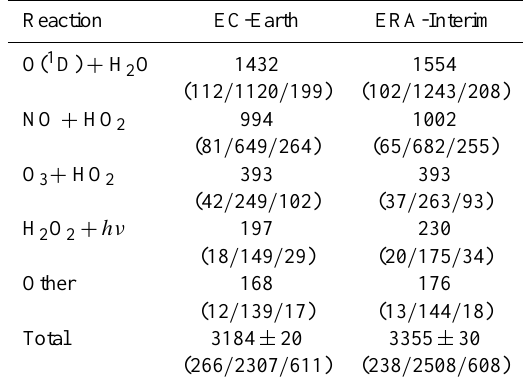
Table 3. Contributions to the chemical production of OH in the troposphere (TgOHyear − 1 ) for the reference EC-Earth simula- tion and the corresponding ERA-Interim simulation. The contribu- tions from 90–30 ◦ S, 30 ◦ S–30 ◦ N, and 30–90 ◦ N are given by the numbers between parentheses. Results have been obtained from a monthly analysis with a fixed tropopause level, set to the uppermost model layer for which the monthly mean O 3 mixing ratio is below 150ppbv. Standard deviations are based on the simulated interan- nual